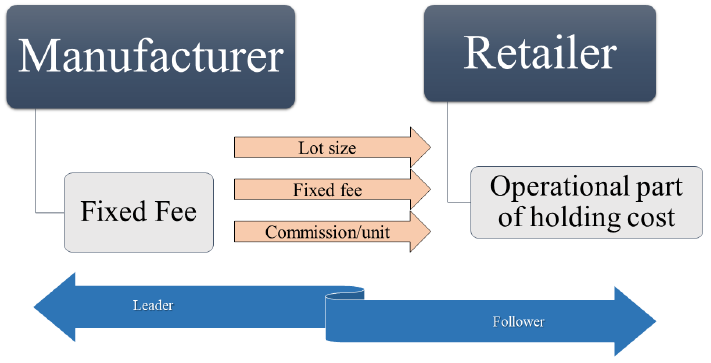
Figure 2. Consignment